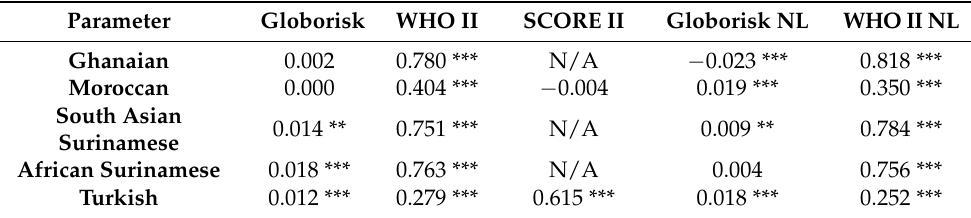
Table 7. Agreement in cardiovascular risk classification among the Netherlands’ specific risk scores and the country-of-birth risk score within the individual ethnic groups. Parameter Globorisk WHO II SCORE II Globorisk NL WHO II